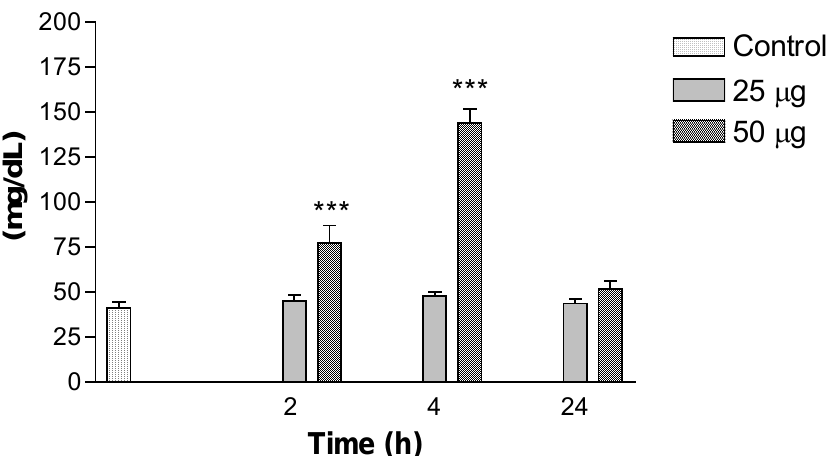
Figure 6: Variations in urea levels in mice intraperitoneally injected with 25 or 50 μ g of Bothrops jararacussu venom diluted with 0.1ml PBS. Each bar represents the mean and vertical lines, the standard error of mean (S.E.M.) of results obtained from 6